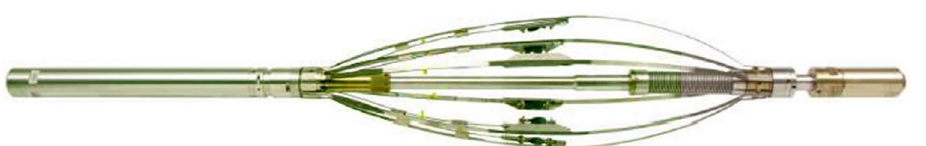
Fig. 4 General view of spinner array tool